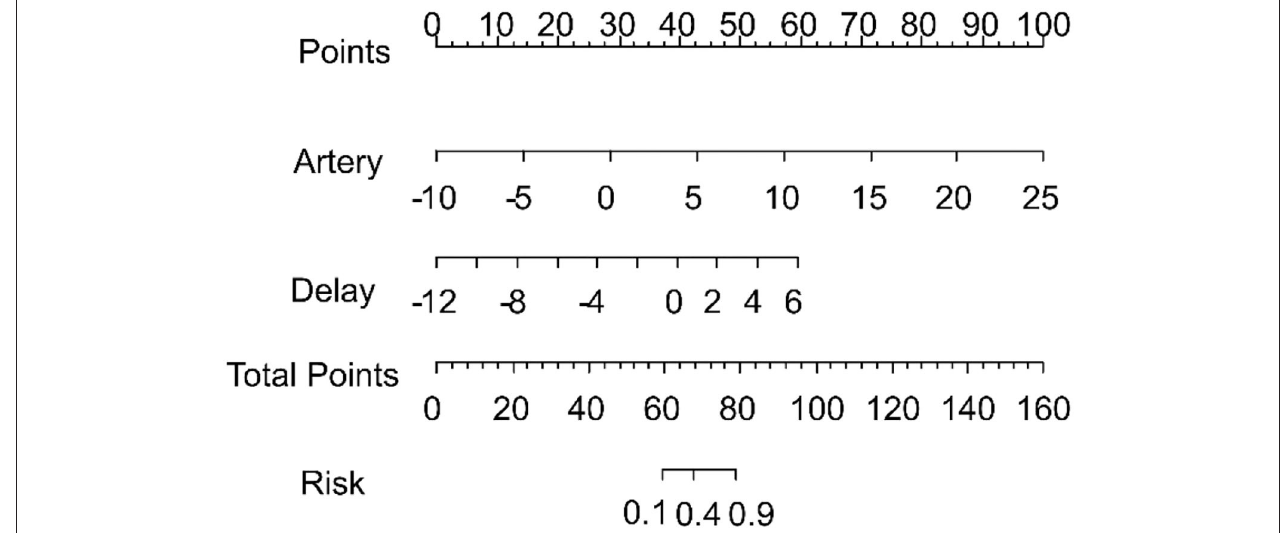
FIGURE 6 | Nomogram combining the radiomics signature from the arterial and delay phases for predicting microvascular invasion. The total score was calculated, and the risk of MVI is shown to go up in the x-axis.